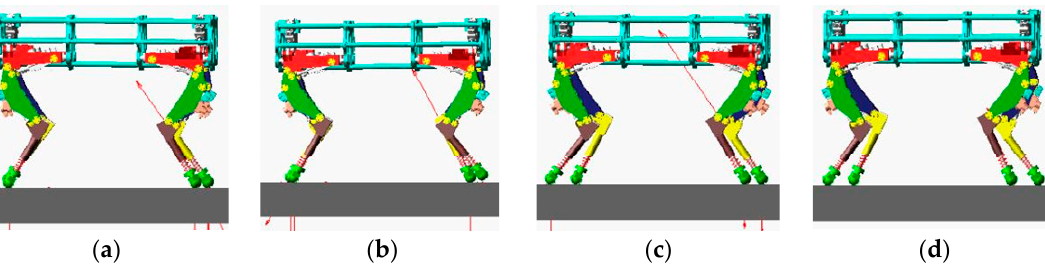
Figure 7. Snapshots of the robot pacing on the flat ground. ( a ) Initial stage. ( b ) The right foreleg (RF) and the right hindleg (RH) are in the swing stage. ( c ) The left foreleg (LF) and left hindleg (LH) are in the swing stage. ( d ) Four legs are in the supporting stage.